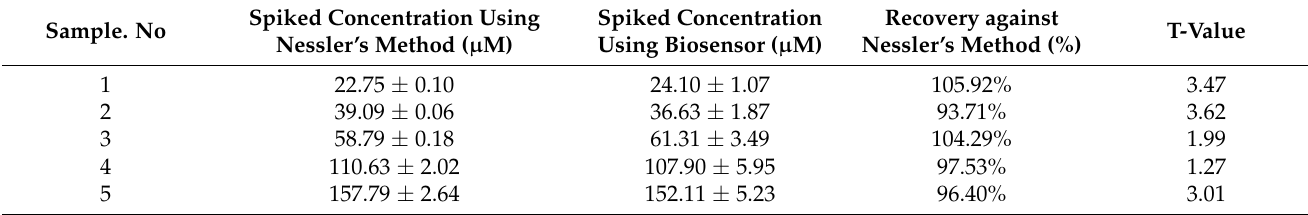
Table 2. Comparison of biosensor and Nessler’s method for the detection of spiked pond water ( n = 3). Sample. No